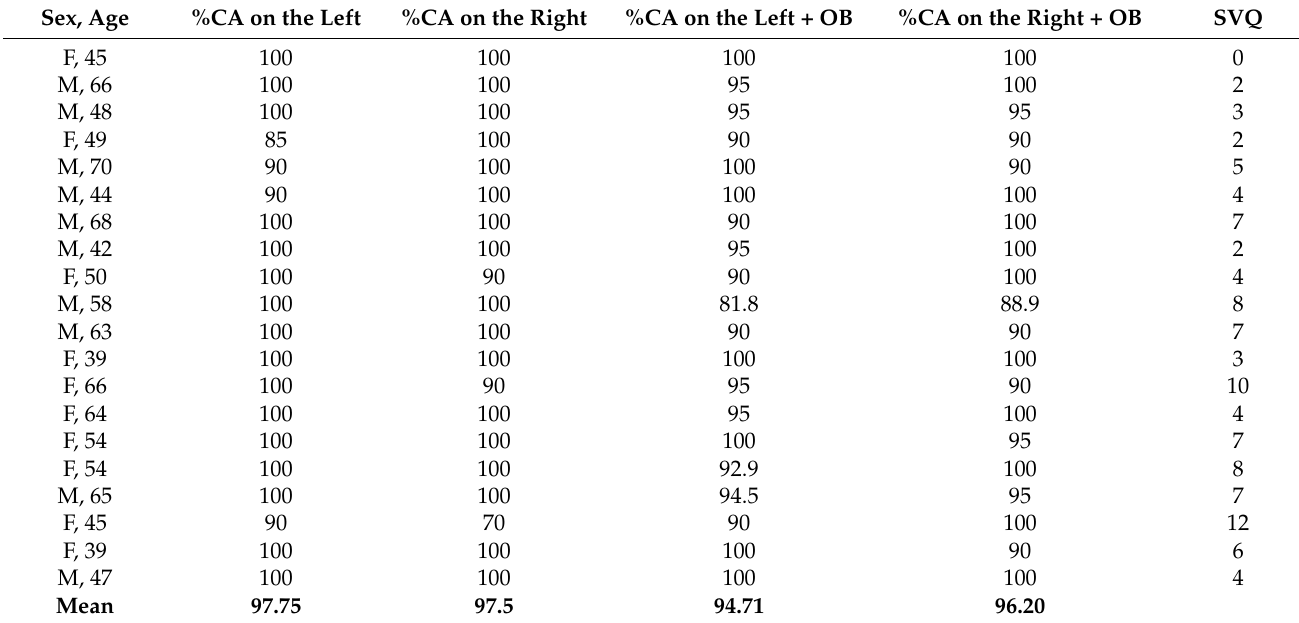
Table 3. The control group (CTRL): demographic data, distribution of percentage of correct answers (%CA) on the left and right sides, without and with the optokinetic background (OB), and situational vertigo questionnaire (SVQ) score. Sex, Age %CA on the Left %CA on the Right %CA on the Left +